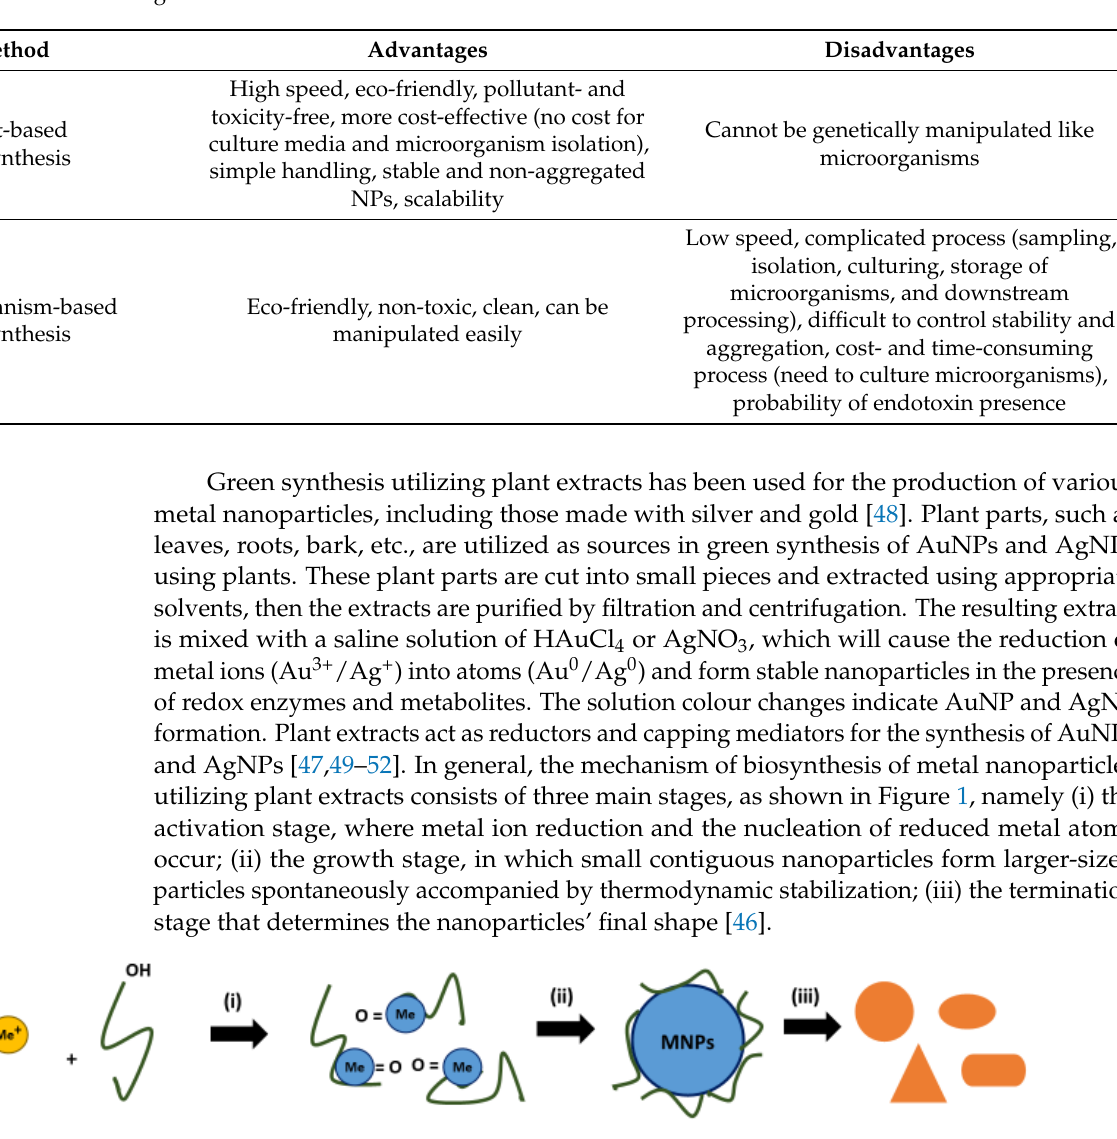
Table 1. Advantages and disadvantages of green synthesis of NPs using plant extracts and micro- organisms.